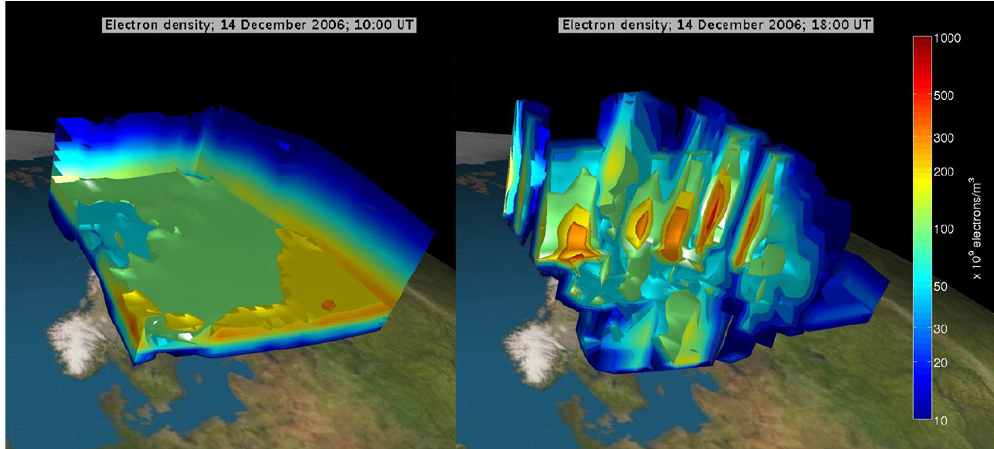
Fig. 13. Two snapshots of the 3-dimensional inversion results for 14